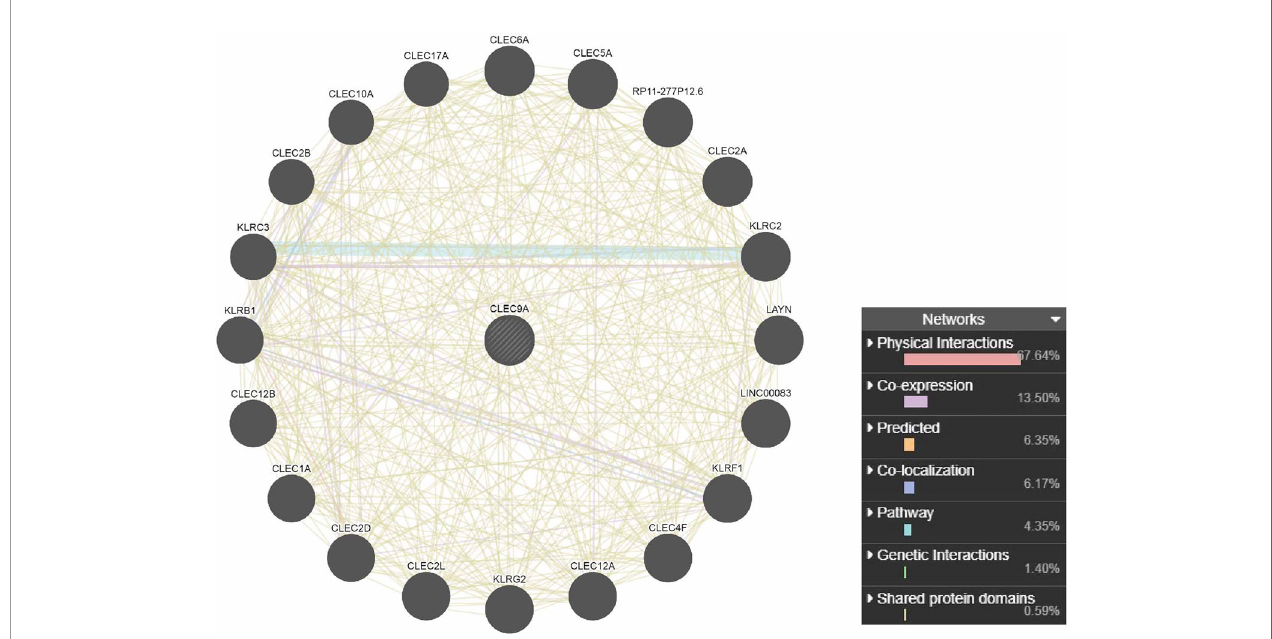
FIGURE 4 | PPI network analysis of interacting genes with CLEC9A. Circles are used to represent nodes, and lines are used to represent edges.